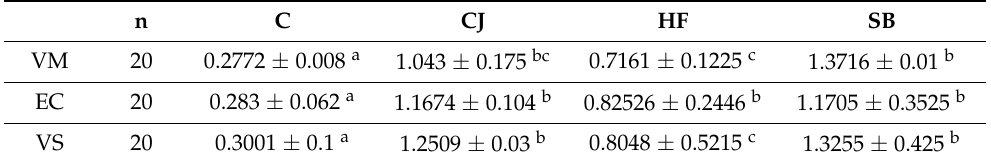
Table 3. Means and standard deviations of surface roughness values for control and treated groups.